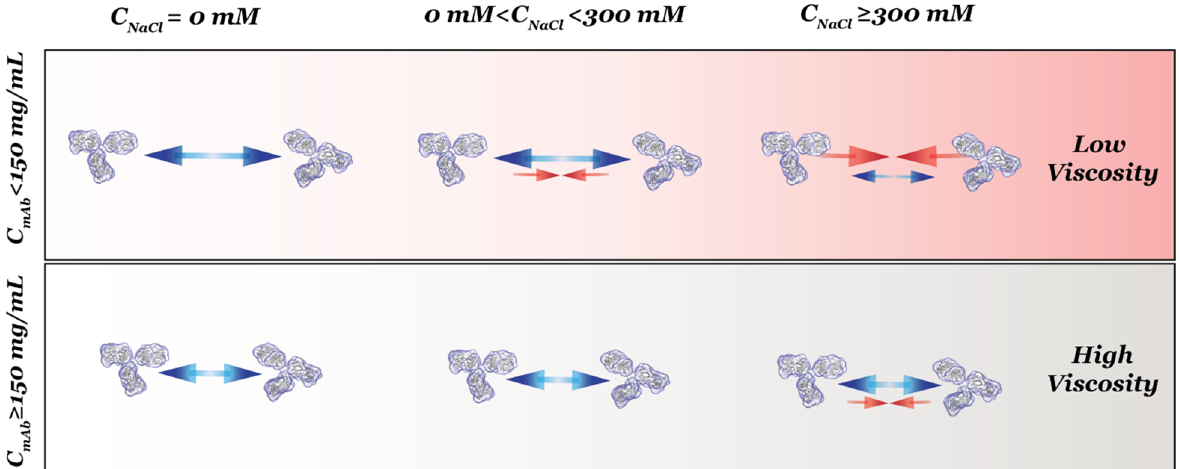
Figure 8. Illustration of PPI among ASA-IgG2 under conditions varying in mAb and NaCl concentrations. The two rows represent samples prepared with C mAb either below or above a critical concentration of 150 mg/mL, while the columns are divided into three C NaCl regimes. Blue and red arrows represent repulsive and attractive inter-protein interactions, respectively. Dominating interactions are illustrated with bigger arrows, whereas non-dominating interactions are illustrated with smaller arrows.